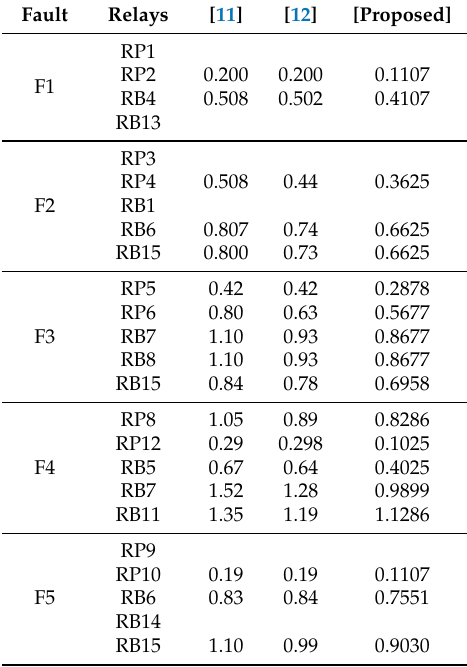
Table 8. Operation times for